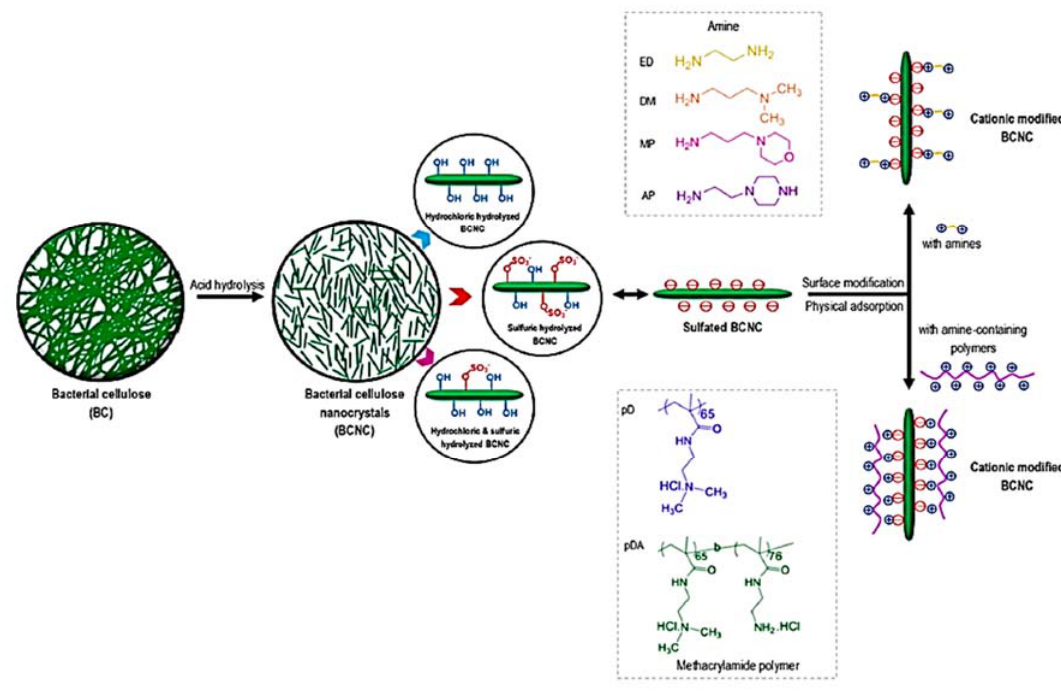
Figure 5. Processing of BC crystals by acid hydrolysis and cationic surface modification of sulfated BC by physical adsorption using amines and amine-containing polymers. Reprinted with permission from [25]. Copyright (2018) American Chemical Society.